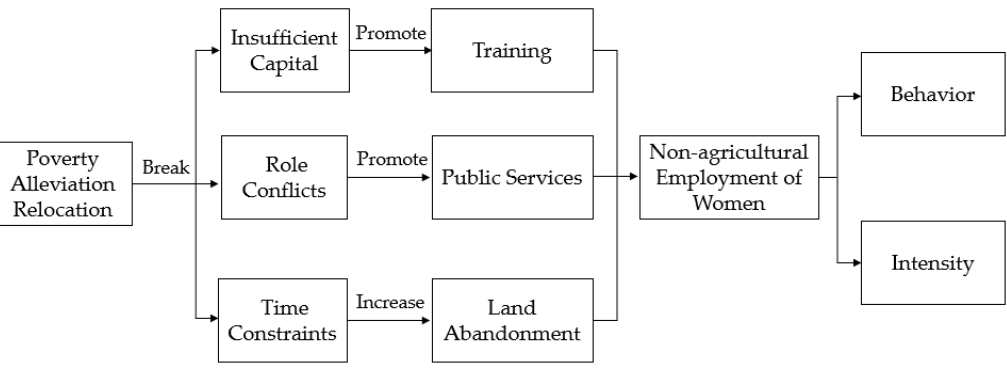
Figure 1. Theoretical framework of poverty alleviation relocation and women’s non-agricultural employment.